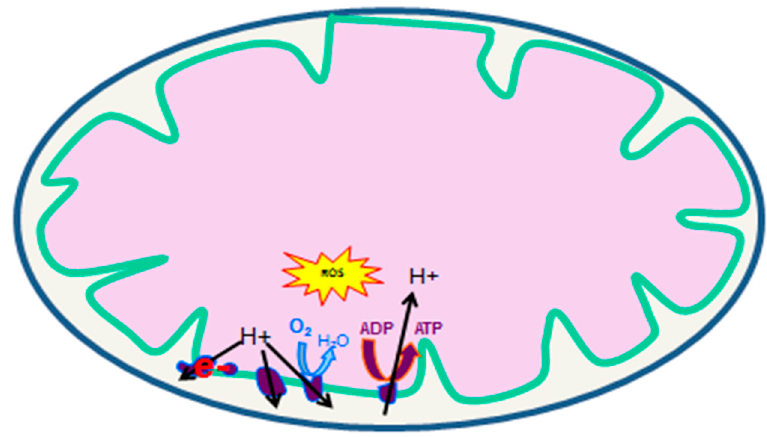
Figure 1. Mitochondrial respiratory chain complexes (Modified from [17]).